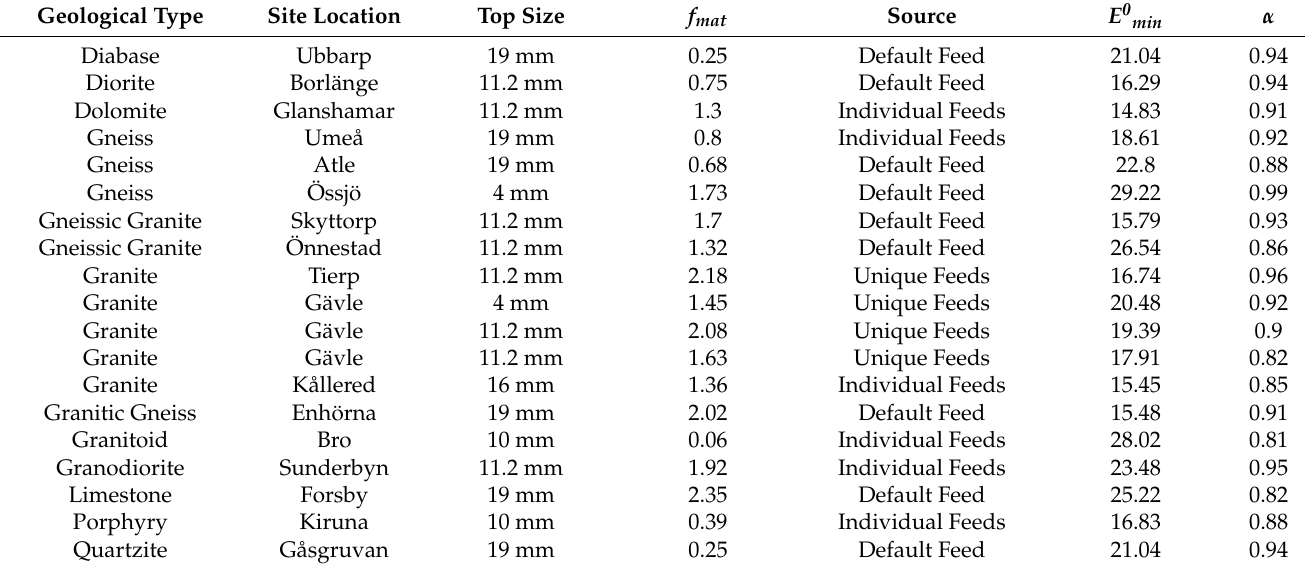
Table 3. Material data from all the sites used in the study, along with their locations and calibrated values. Geological